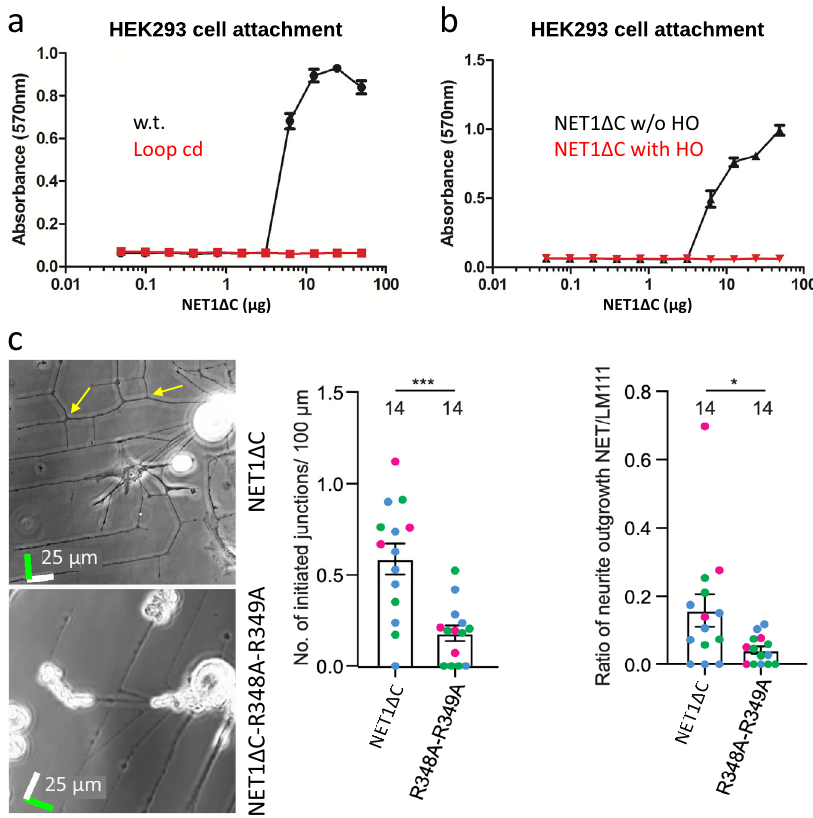
Fig. 6 | Physiological relevance of the NET1 Δ C-GAG interaction. a Cell- attachment assay of wild type NET1 Δ C in comparison to NET1 Δ C-loop cd mutant. b Cell-attachment studies showthatHO-dp20 isblocking NET1 Δ C cellattachment. c Neuronal branching points (yellow arrows) of sensory neurons cultured on printed substrates. Bands of laminin-111 substrates were crossed with stripes of NET1 Δ CandtheNET1 Δ CCardin-WeintraubRRdoublemutant.Scalebarsrepresent 25 µ m and white bars indicate the direction of laminin-111 bands. Green depicts